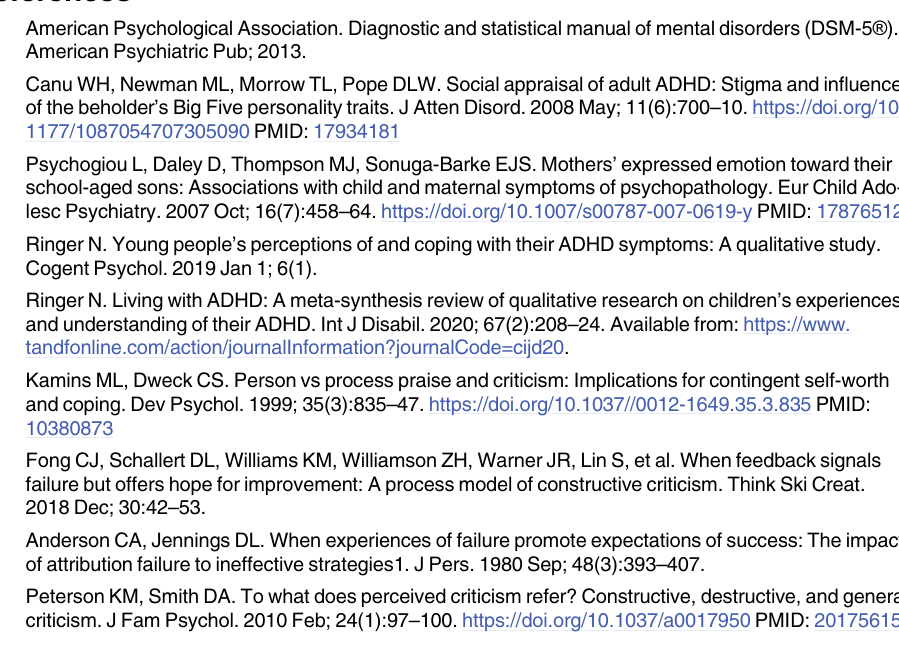
S1 Table. The codebook developed for the thematic